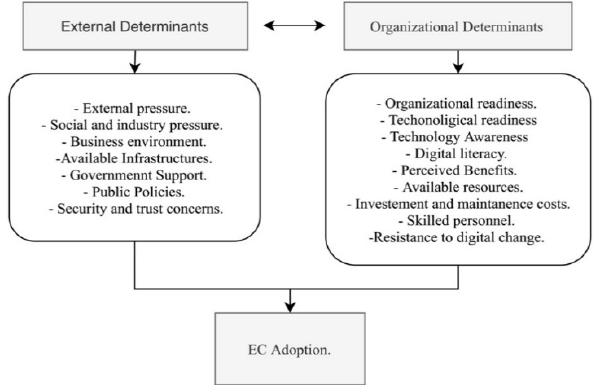
Figure 2. Determinants of EC adoption in SMEs.